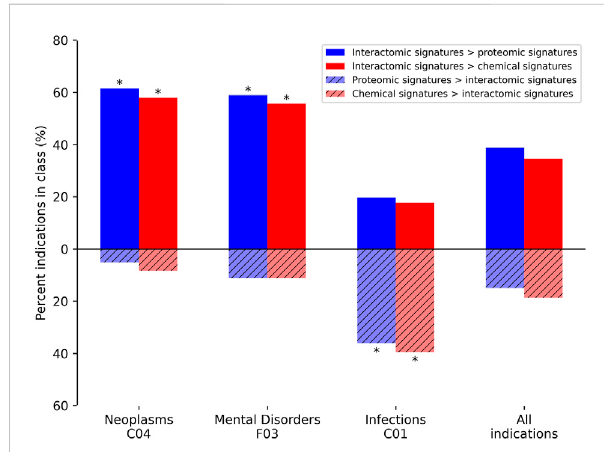
FIGURE 5 Comparative benchmarking performance by various CANDO pipelines for speci fi c indication classes. The most overrepresented classes of indications, based on their upper level Medical Subject Heading (MeSH) (Lipscomb, 2000)), with changes in benchmarking accuracy for the interactomic signatures compared to both the proteomic and chemical signatures are depicted. The average indication accuracy of the multiscale interactomic pipeline of 28.1% exceeded those of the proteomic and chemical signature pipelines of 20.7% and 23.6%, respectively (section 4.3; Figure 4). The interactomic signatures de fi nitively outperformed the proteomic signatures (solid blue) and chemical signatures/ fi ngerprints (solid